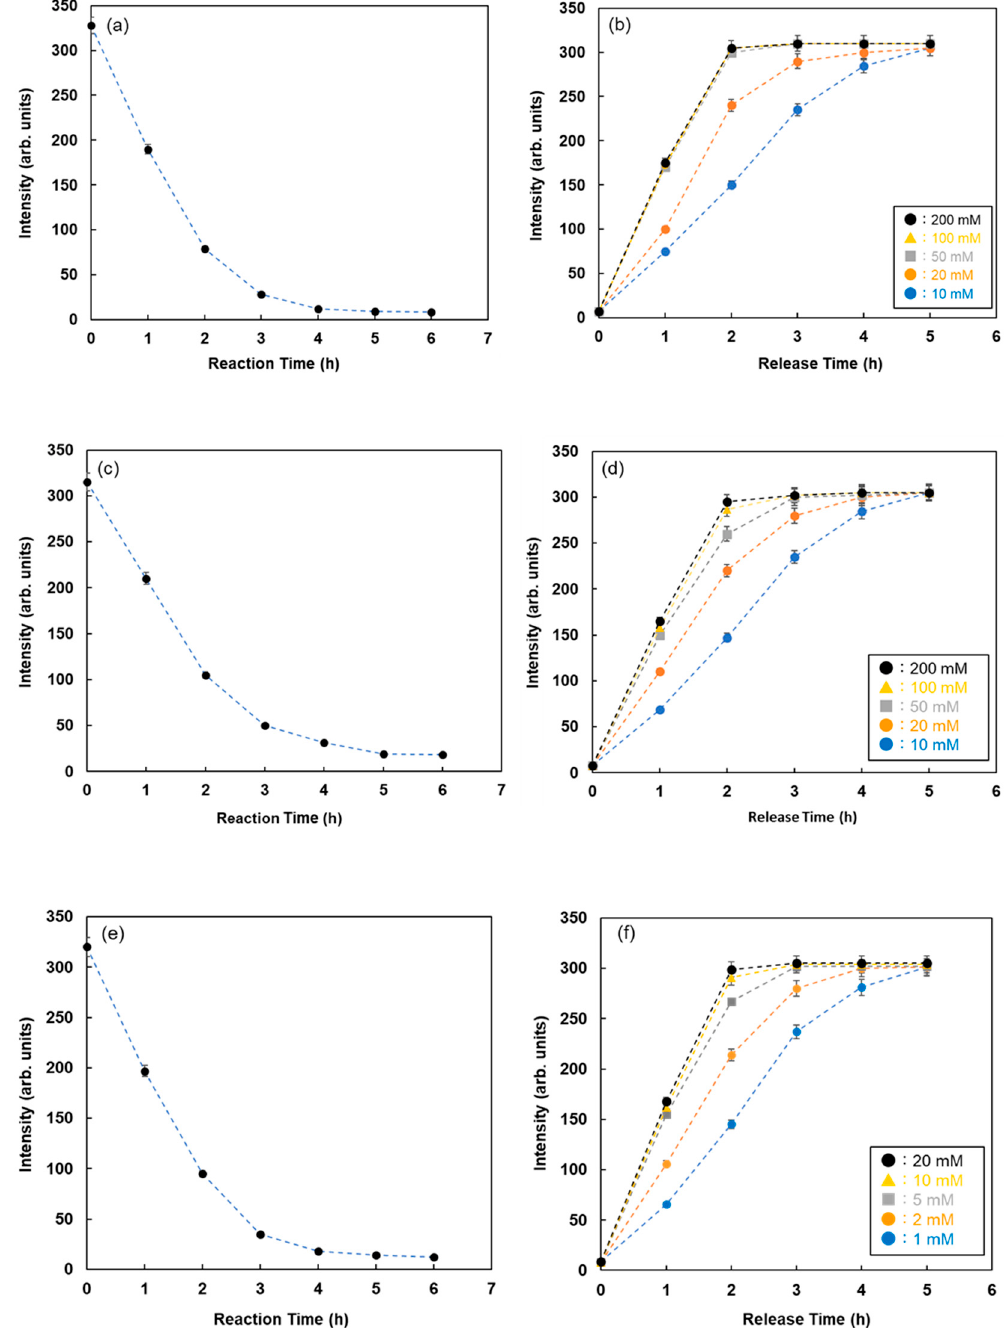
Figure 5. Fluorescence intensities of FMB-Con A with time after the addition of RNase-B modified using Quen-I ( a ) and after the addition of various concentrations of maltose as the inhibitor sugar ( b ). Fluorescence intensities of FMB-WGA with time after the addition of ovalbumin modified using Quen-I ( c ) and after the addition of various concentrations of N-acetyl-D-glucosamine as the inhibitor sugar ( d ). Fluorescence intensities of FMB-UEA-1 with time after the addition of mucin modified using Quen-I ( e ) and after the addition of various concentrations of α -L-Fucose as the inhibitor sugar ( f ). [FMB-Con A] = [FMB-WGA] = [FMB-UEA-1] =10 μ g/mL; [RNase-B] = [Ovalbumin] = [Mucin] =10.0 ng/mL; Solvent, PBS buffer solution, pH 7.0; Fluorescence measured at 575 nm; Excitation wavelength, 550 nm.